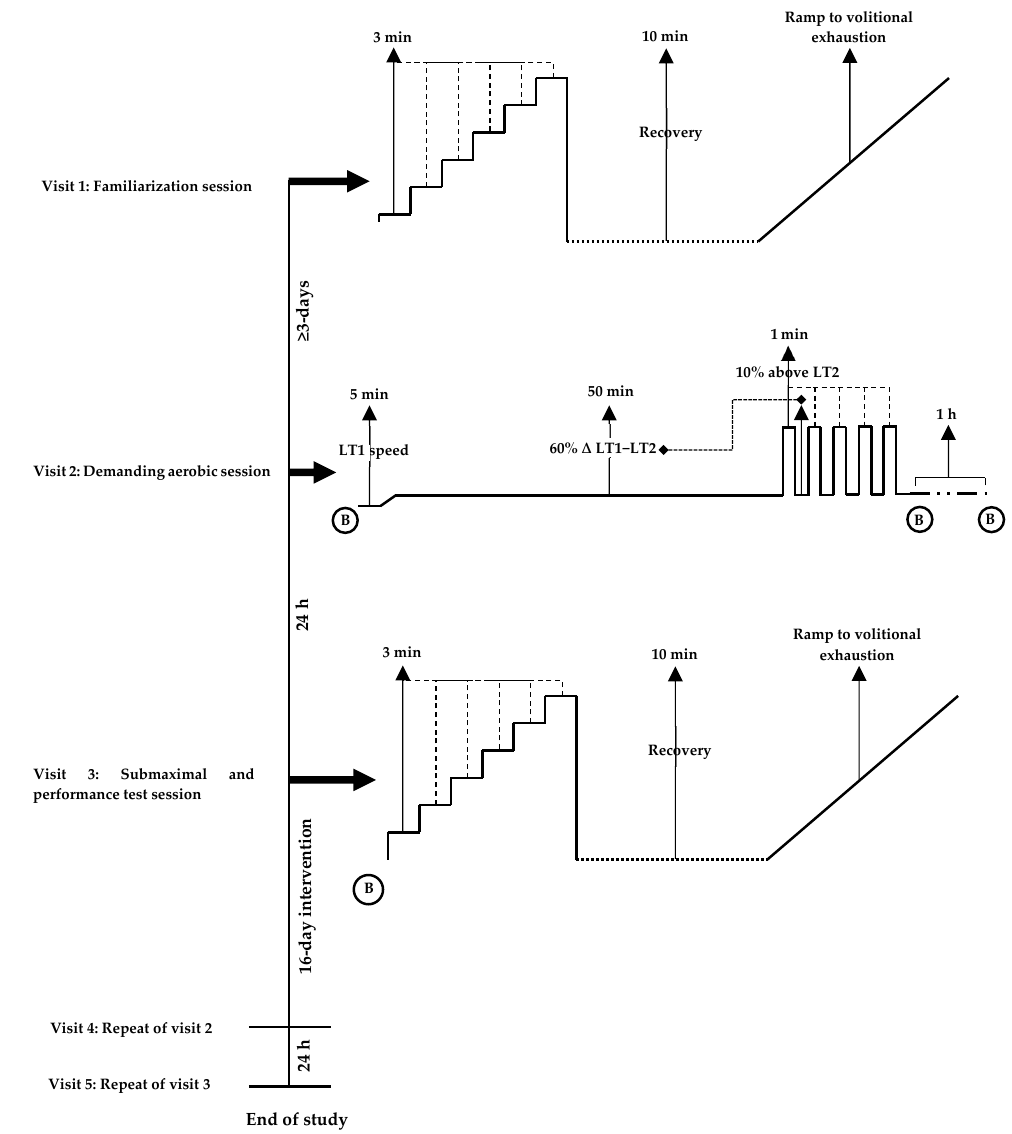
Figure 1. Schematic of study protocol outlining the familiarization (visit 1), demanding aerobic session (visit 2) and submaximal and performance test session (visit 3). B = blood sample; LT1 = lactate threshold; LT2 = lactate